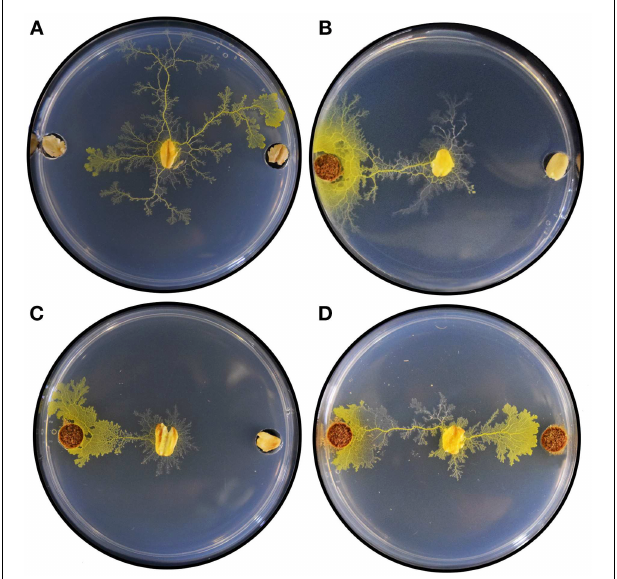
FIGURE 4 | Selected results of plasmodium binary choice experiments. (A) Plasmodia inoculated onto assay plates containing oat flake in both sample locations extended concentrically onto the agar substrate, ultimately establishing a leading front toward one or both oat flakes. (B) Exemplary result of binary choice experiments between wild type V. officinalis plant root and oat. (C) Exemplary result of binary choice experiments between V. officinalis VoHR5 hairy root and oat. (D) Exemplary result of an equal preference event. Plasmodium chose both wild type plant root (left) and hairy root (right)